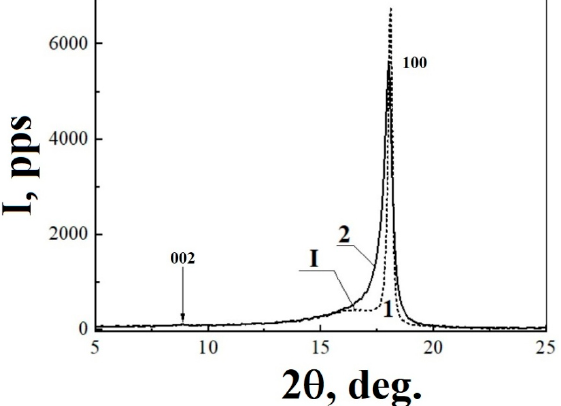
Note: 2 θ max , deg. is the position of the maximum of the diffraction peak in the X-ray spectrum; I , pps (pulse per second) is the intensity of the diffraction maximum; I / I max , % is the relative intensity of the diffraction maxima in the X-ray spectrum.